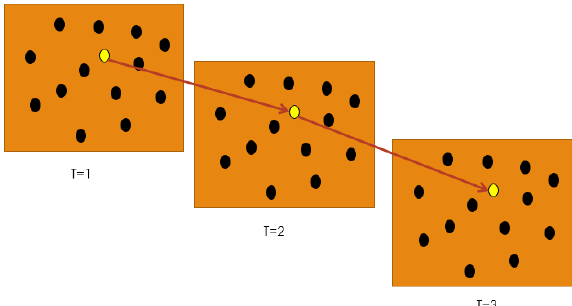
Figure 1. Mesh method. The yellow point is the robust solution found by the method and it is used in the next